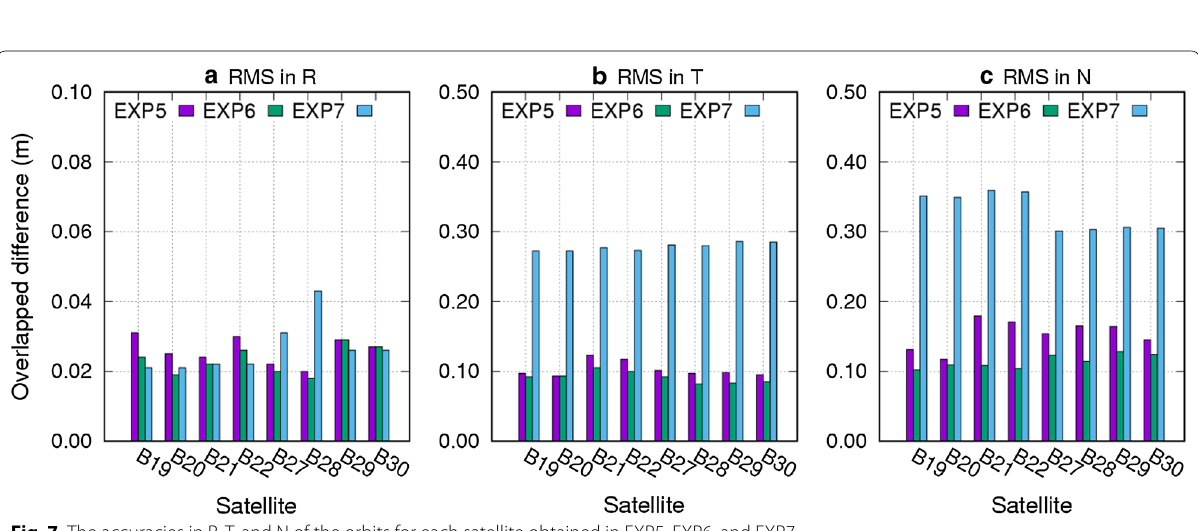
Since the ISL of BDS-3 runs in a TDMA mode, the Ka- pseudorange observations at a certain satellite are gen- erated at different times, and each observation contains two unique clock offset parameters that remove redun- dant observations. Existing methods for OD and TS with